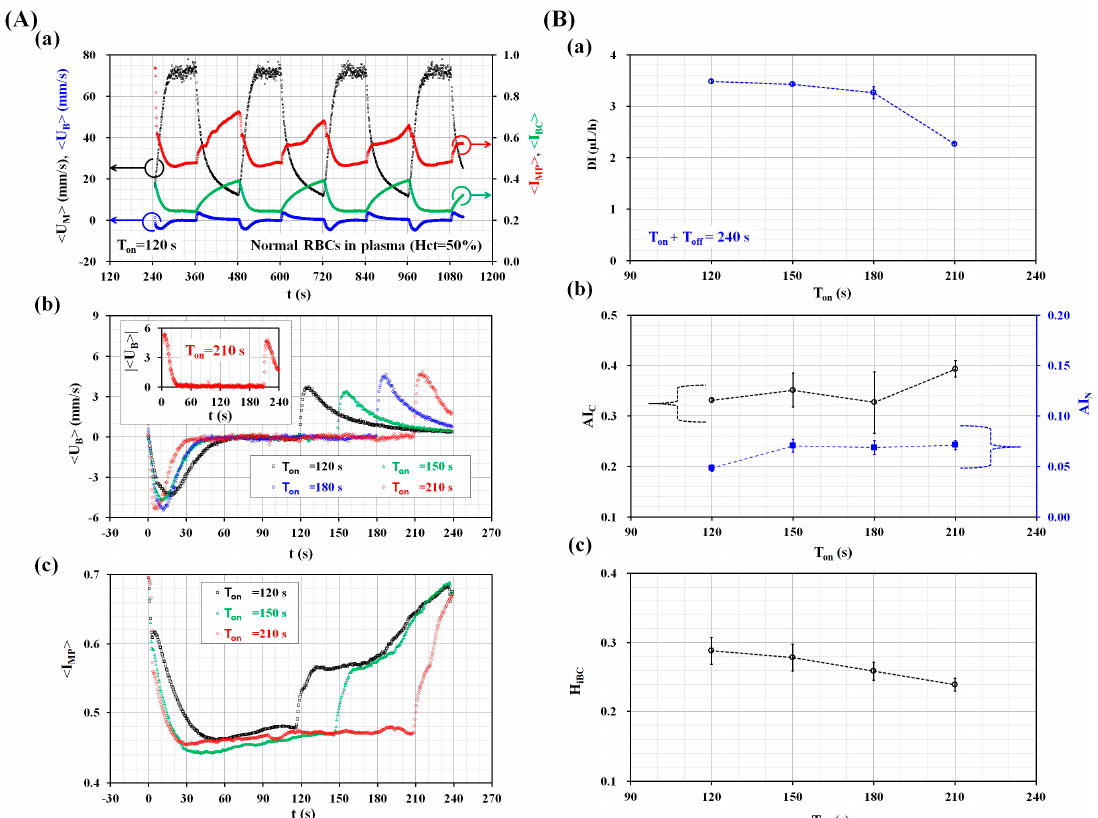
Figure 2. Quantitative evaluations of the effect of turn-on time (T on ) on the four biophysical indices (i.e., DI, AI C , AI N , and H iBC ). ( A ) Temporal variations of four parameters (<U M >, <U B >, <I BC >, and <I MP >). The hematocrit of blood was adjusted to 50% by adding normal RBCs into autologous plasma. ( a ) Temporal variations of averaged blood velocities (<U M >, and <U B >) and averaged image intensities (<I BC >, and <I MP >) at the turn-on time of T on = 120 s. ( b ) Temporal variations of <U B > by increasing turn-on time (T on ) (T on = 120 s, 150 s, 180 s, and 210 s). Inset showed temporal variations of |<U> b | at the turn-on time of T on = 210 s. ( c ) Temporal variations of <I MP > with respect to the turn-on time (T on ) (T on = 120 s, 150 s, and 210 s). ( B ) Variations of four biophysical indices (DI, AI C , AI N , and H iBC ). ( a ) Variations of RBC deformability (DI) with respect to T on . ( b ) Variations of a conventional RBC aggregation index (AI C ) and new RBC aggregation index (AI N ) with respect to T on . ( c ) Variations of hematocrit index (H iBC ) with respect to T on